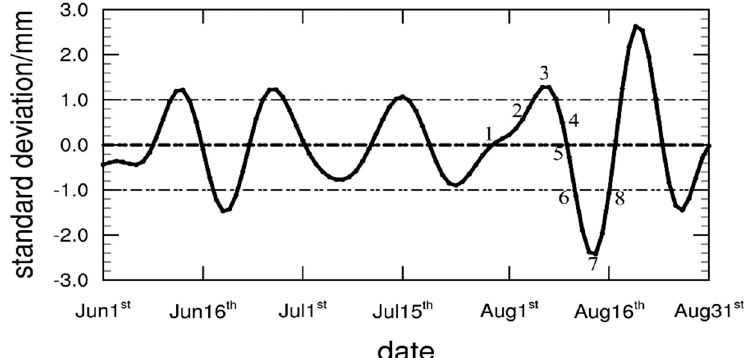
Figure 1. The daily 10–20 d filtered rainfall time series from June to August (June–July–August) in 2012. (the gray dashed line is 1 times standard deviation of filtered precipitation time series, numbers 1–8 denote low-frequency oscillation phase, units: mm).